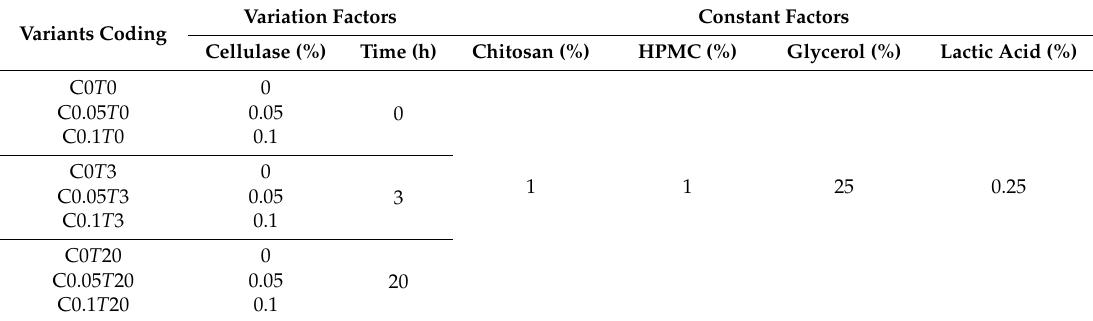
Table 3. Experimental